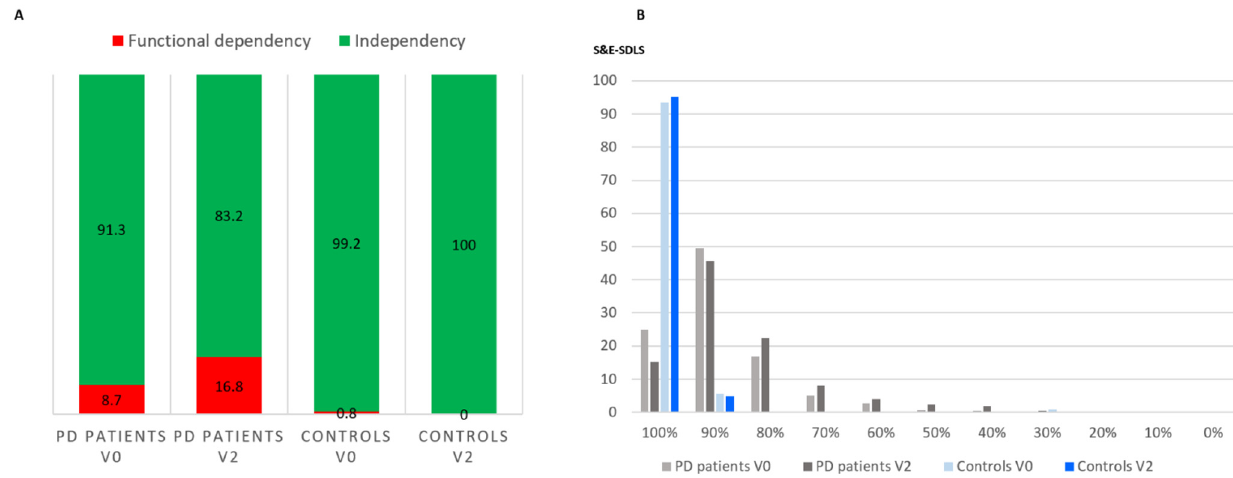
Figure 2. ( A ) Frequency of PD patients and controls presenting functional dependency (S&E-ADLS score < 80%) at V0 and at V2. p -values < 0.0001 for functional dependency in PD patients at V2 vs. at V0, in PD patients at V0 vs. in controls at V0, and in PD patients at V2 vs. in controls at V0; ( B ) frequency of PD patients (N = 507; in grey) and controls (N = 124; in blue) presenting different scores in the S&E-ADLS at V0 (baseline) and at V2 (2 years ± 30 days). PD, Parkinson’s disease; S&E-ADLS, Schwab & England Activities of Daily Living Scale.